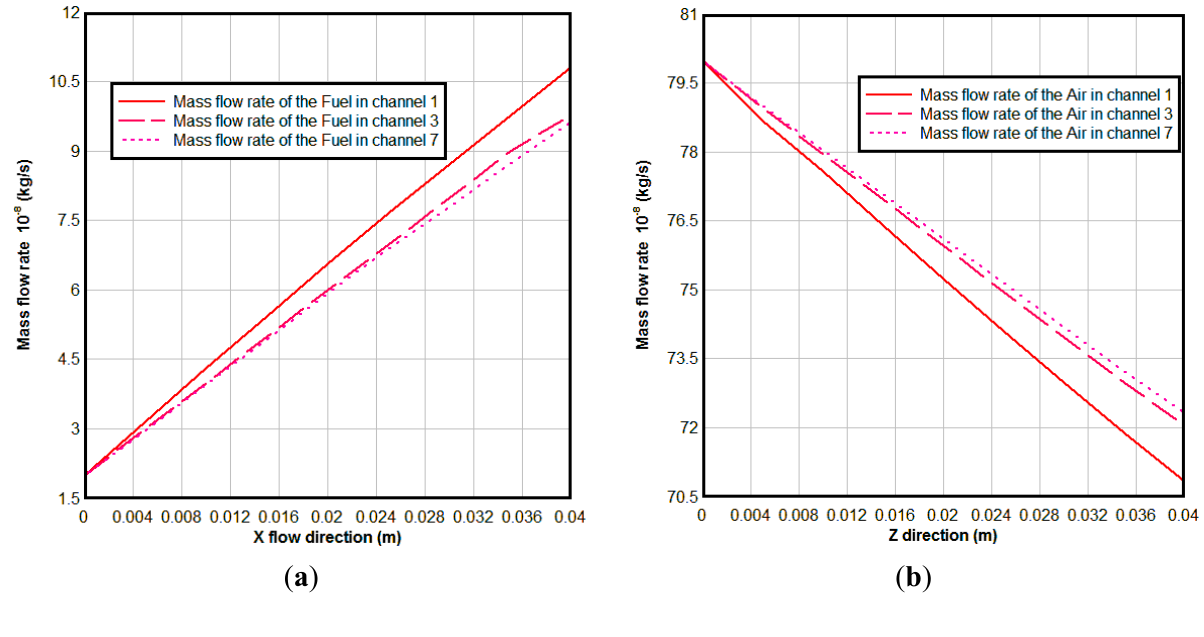
Figure 8. Mass flow rate of the gas in: ( a ) fuel; ( b ) air